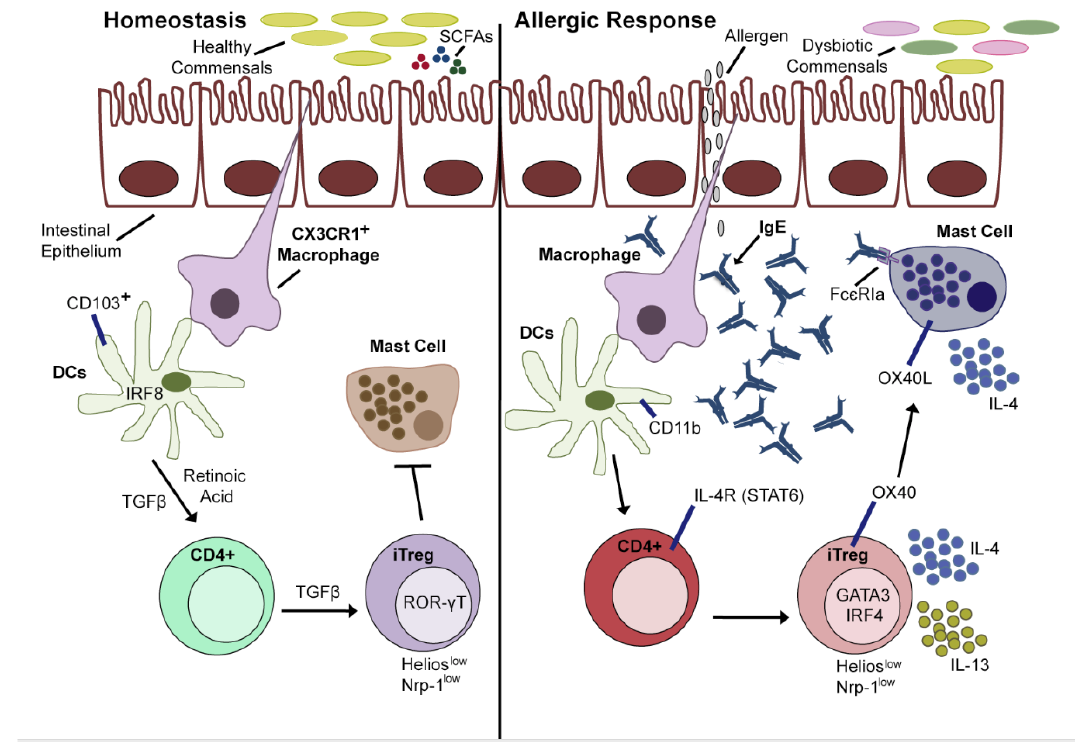
Figure 2. Mucosal tolerance in the gut and its breakdown in food allergy. ( Left ) Under homeostatic conditions, CX3CR1 + macrophages sample components of the gut lumen and transfer luminal antigens to IRF8 + CD103 + dendritic cells (DCs), which in turn promote the formation of antigen-specific induced regulatory T (iTreg) cells. iTreg cells expressing retinoid-related orphan receptor gamma t (RoR- γ t) may regulate tolerance to dietary antigens by a range of mechanisms, including the suppression of mast cell activation. iTreg cells may also prevent the conversion of naïve CD4 + T cells to antigen-specific helper T 2 (TH2) cells. ( Right ) Under food allergic conditions, CD11b + CD103 – DCs encounter allergens that are made more accessible by a permeable epithelial barrier. Allergen-presenting DCs drive the differentiation of naïve T cells into allergen-specific TH2 cells expressing the interleukin-4 receptor (IL-4R). iTreg cells also acquire a TH2 cell-like phenotype characterized by increased GATA3 and IRF4 expression and the release of IL-4 and IL-13. These ‘pathogenic’ Treg cells are unable to suppress mast cell activation through engagement of the OX40-OX40 ligand pathway. Binding of IgE to the high-affinity receptor for IgE (Fc ε RI) leads to uninhibited mast cell degranulation and IL-4 production. IRF8, interferon gamma regulatory factor 8; SCFA, short-chain fatty acid; TGF β , transforming growth factor